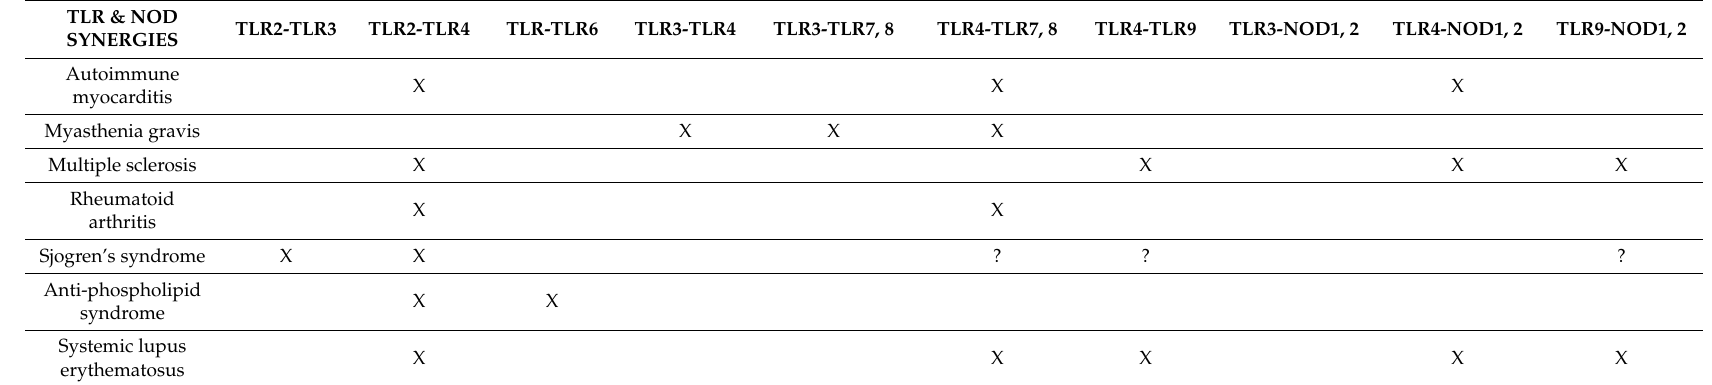
Table 2. Di ff ering patterns of TLR and NOD synergisms associated with various autoimmune diseases based on Table 1 and Figure 7 as well as additional cases in the text. X indicates presence of that synergistic interaction. ? indicates that evidence for the synergism is questionable in light of current evidence (see